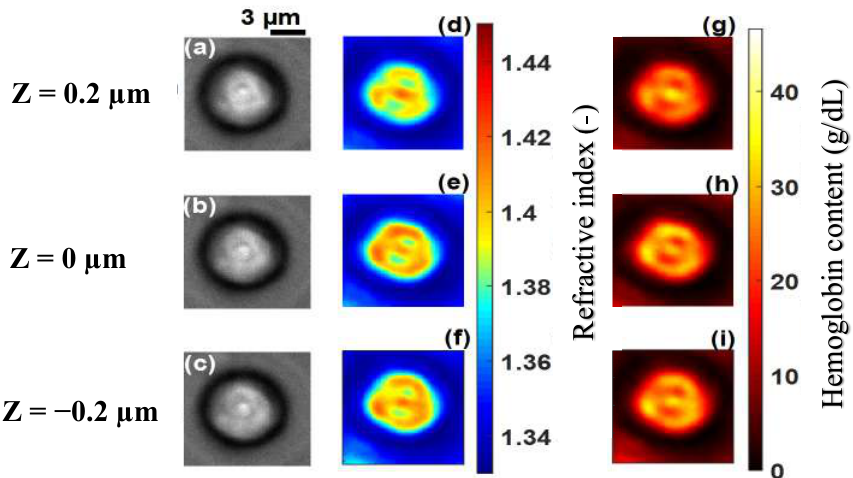
Figure 6. Recorded images of infected cell B at an early stage, at the wavelength λ = 800 nm for different z planes ( a )–( c ), its corresponding refractive index distribution ( d )–( f ) and hemoglobin content ( g )–( i ). The selected images are representative of a total of 68 cells at an early stage.